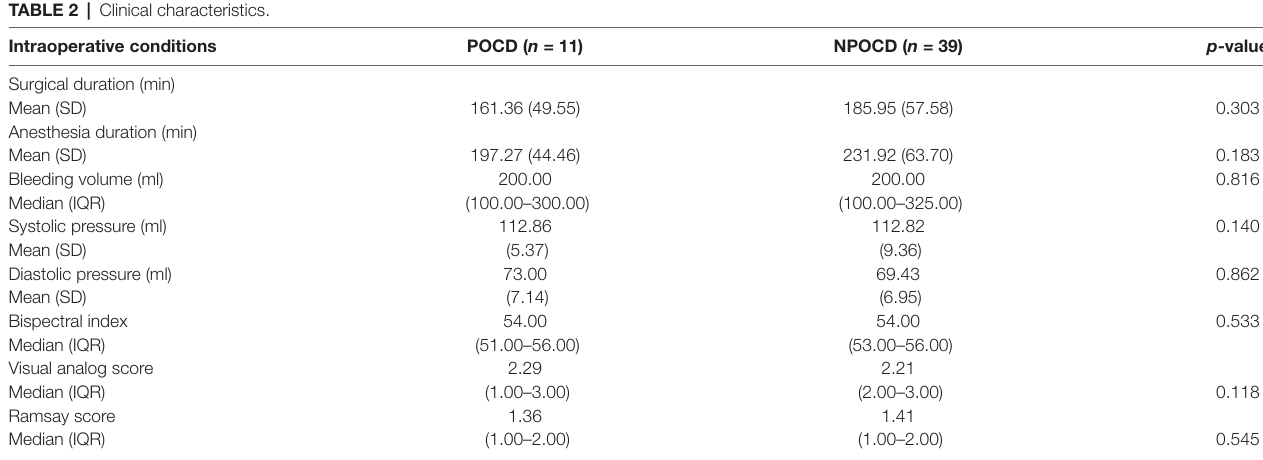
TABLE 2 | Clinical